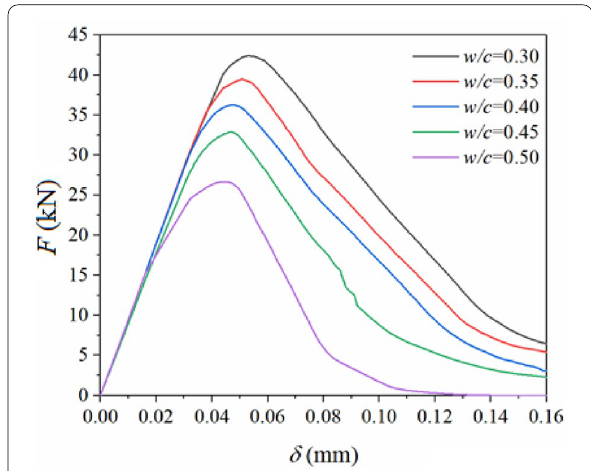
Fig. 13 Load–displacement curves for different mortar water– cement ratios